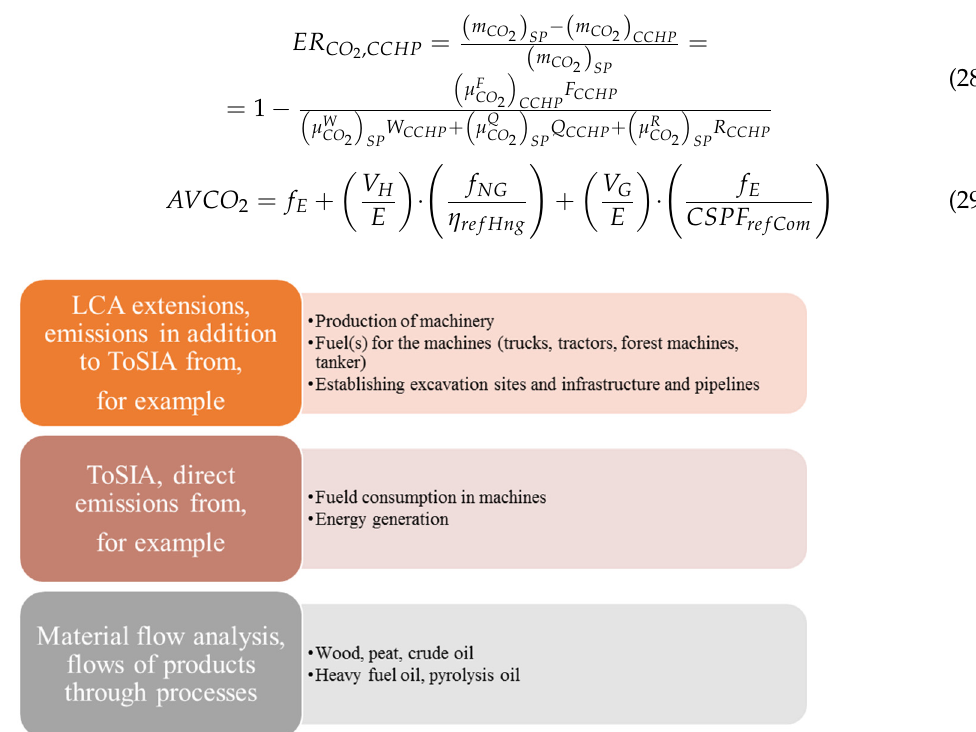
Figure 13. The principle difference between the diverse methodologies of environmental analyses.